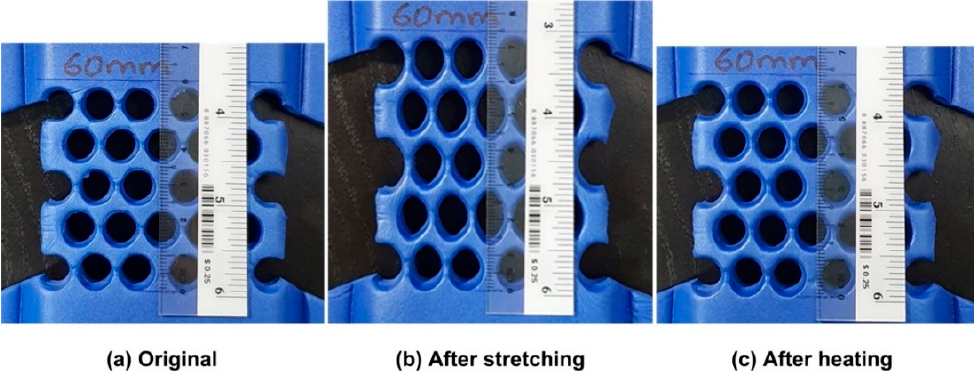
Figure 8. SME (enlarged view of the insole middle area with an array of holes and surrounding ring removed). ( a ) Original; ( b ) After heating and stretching; ( c ) After heating for shape recovery.